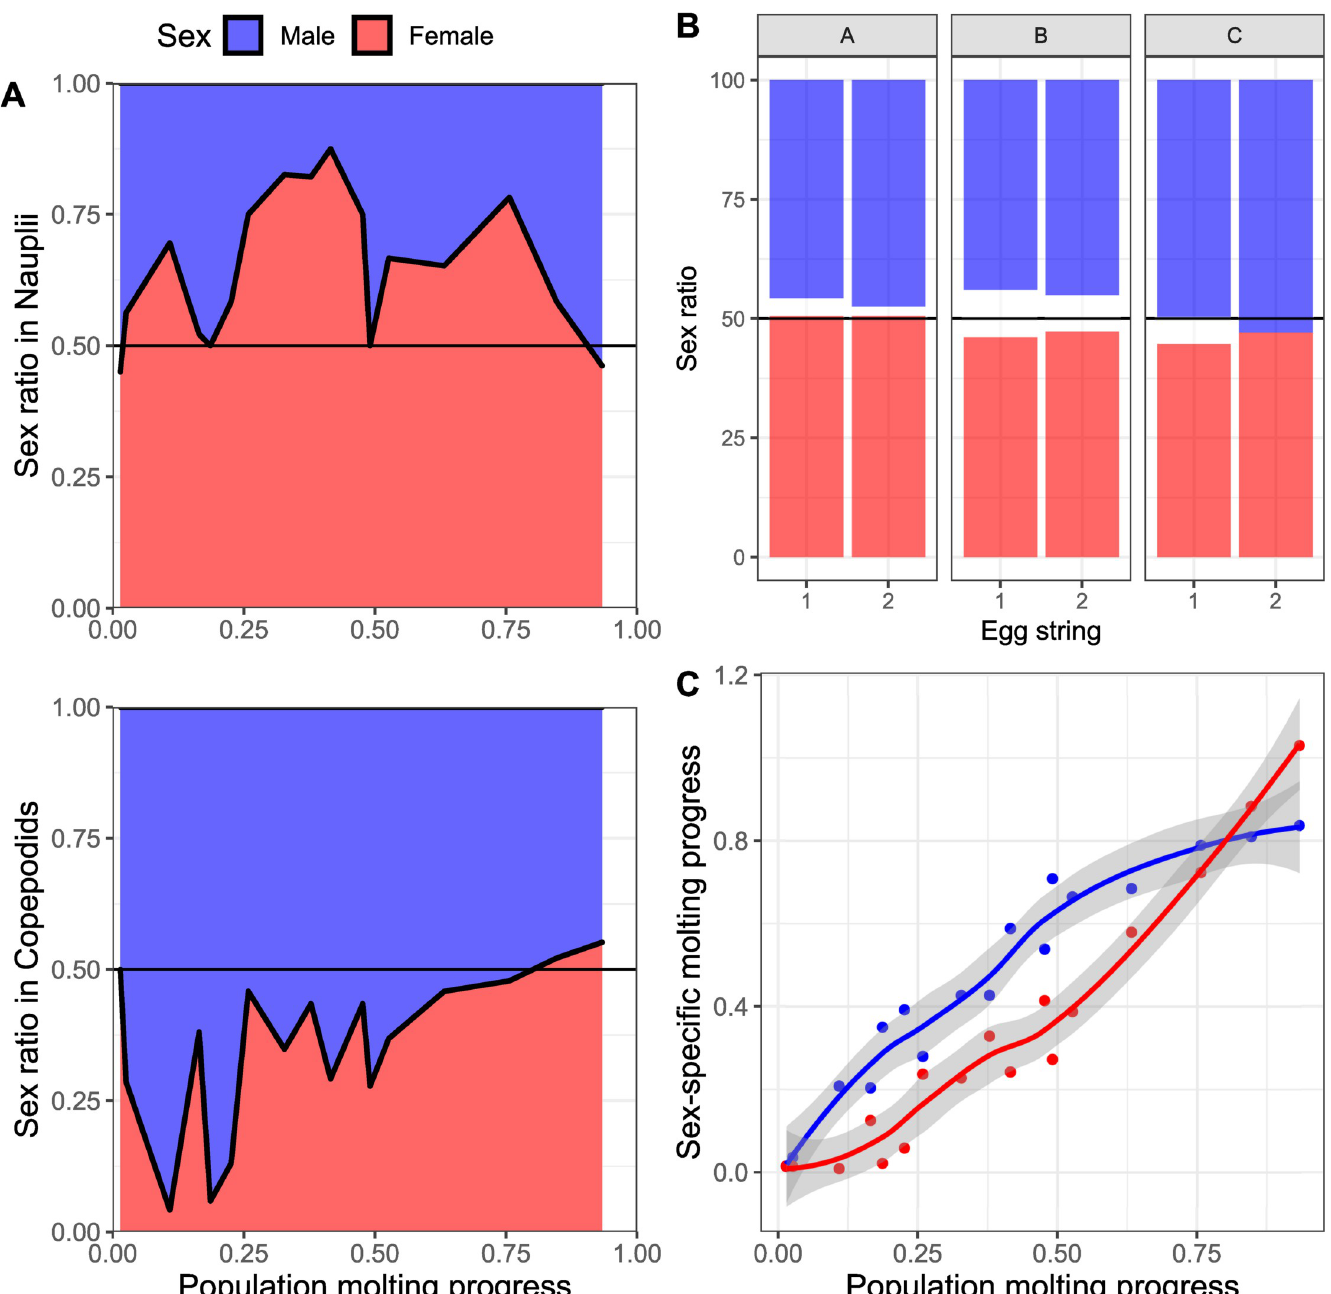
Fig 2. Early-stage sex ratios and sex-specific molting speed. A. Several populations descending from one egg string pair each were sampled at different time points during the molting progress from nauplius II to copepodid. The population molting progress refers to the ratio of animals of the analyzed egg string that had undergone molting to the copepodid stage at sampling. The sex ratio of the nauplius- and copepodid-subpopulations were determined individually in random samples from the population. B. The general sex ratio in the offspring from egg strings was determined at the copepodid stage. Every hatched animal was sexed by PCR. The white areas show animals for which the sex determination was not successful. C. Calculated sex-specific molting progress. Based on the data from A and B, we calculated the sex-specific molting progress, representing the rate of males and females having undergone molting to the copepodid stage relative to the overall population molting progress,